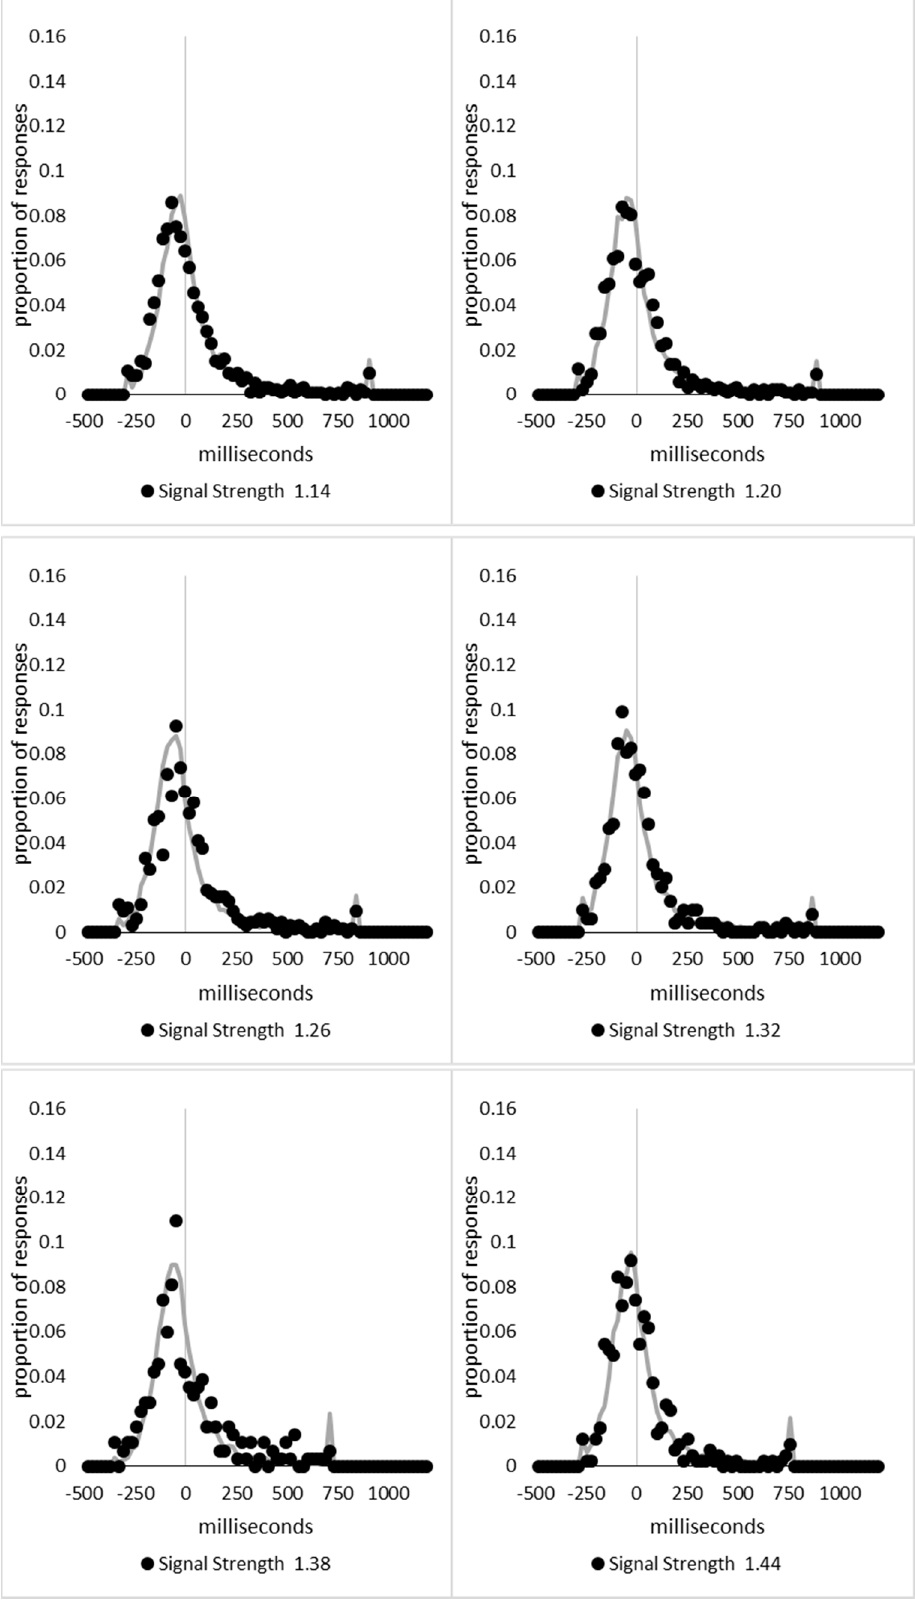
Figure A4. Density functions of the observed data (filled circles) and model (solid line) for signal strength bins 1.14 to 1.44.